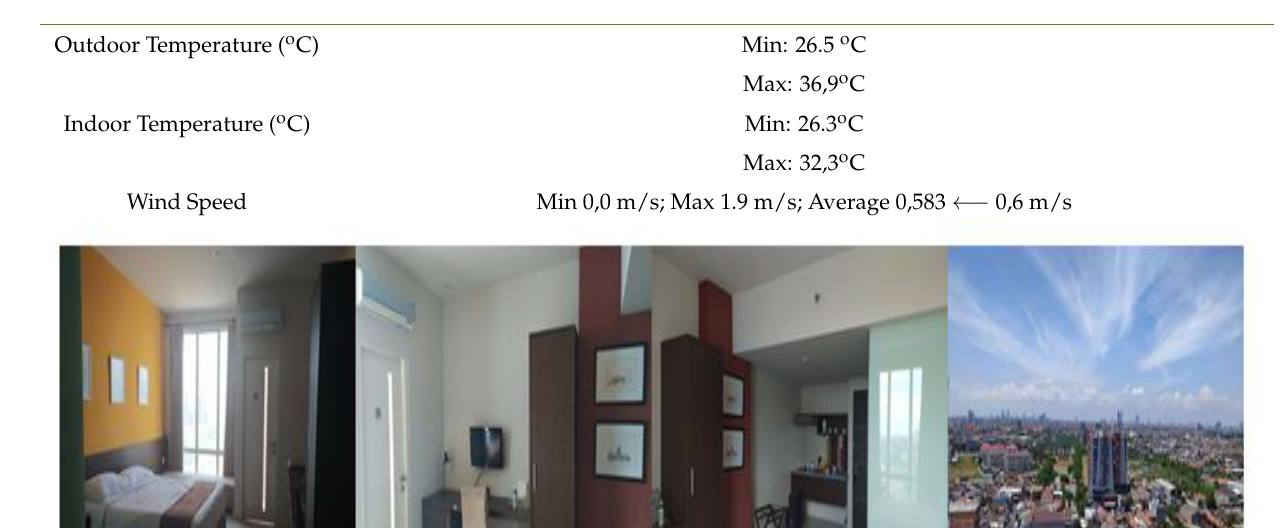
Table 2. Studio Room